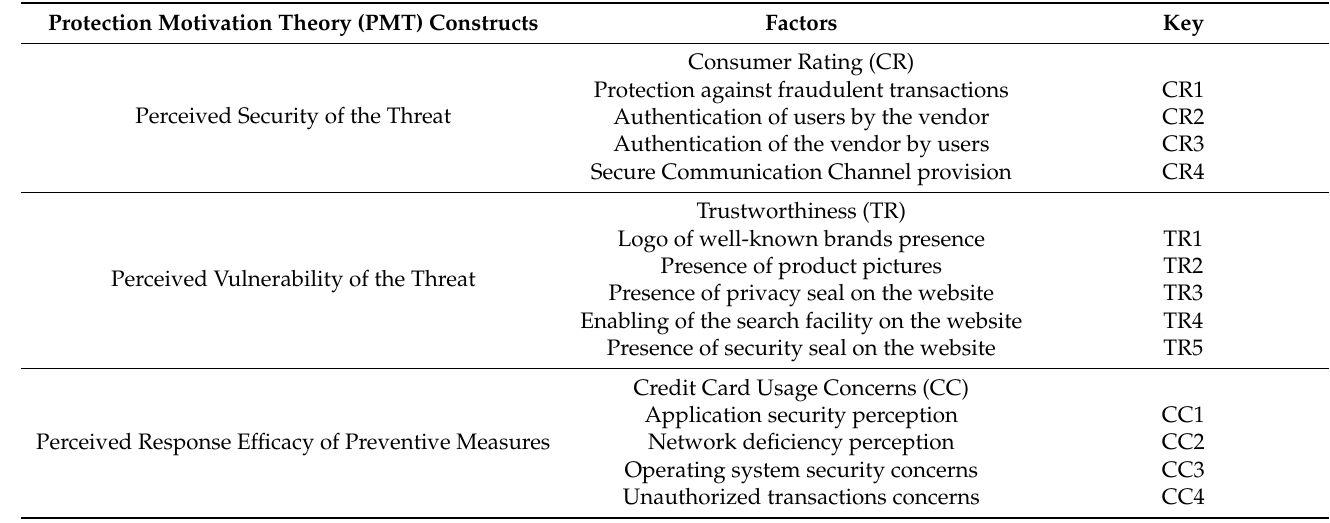
Table 1. Keys for factors in the